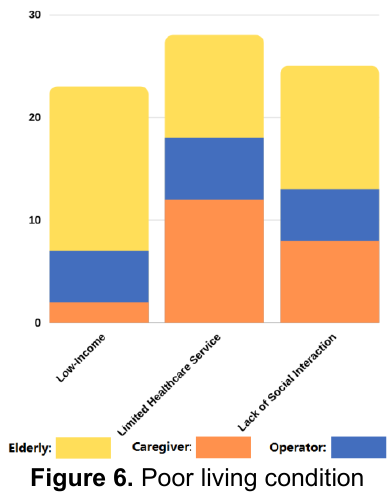
Figure 6. Poor living